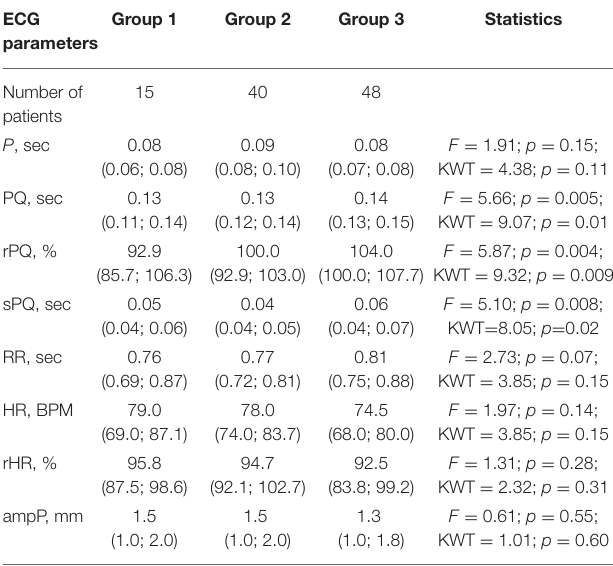
TABLE 3 | ECG parameters in children with different degrees of severity of